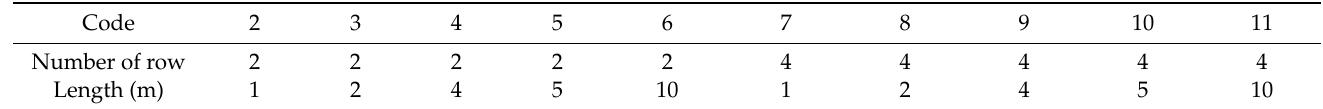
Table 2. Coding of the mosaic size used as training and test datasets for the simulation modeling.